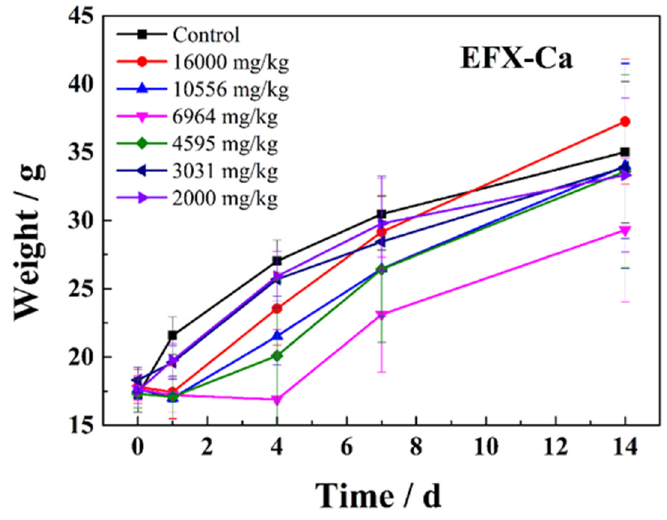
Figure 3. The time-dependent effects on the body weight of the tested KM mice after the oral ad-